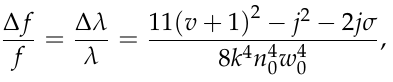
Figure 9. Dependence of the delay time ( a ) and group delay splitting ( b ) on the radial and azimuthal indices, accordingly, z = 1 km, n 0 = 1.5.